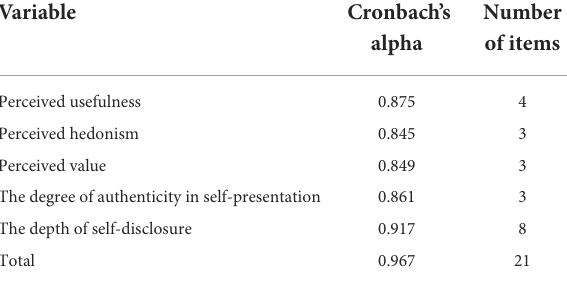
TABLE 4 Result of Cronbach’s alpha test.